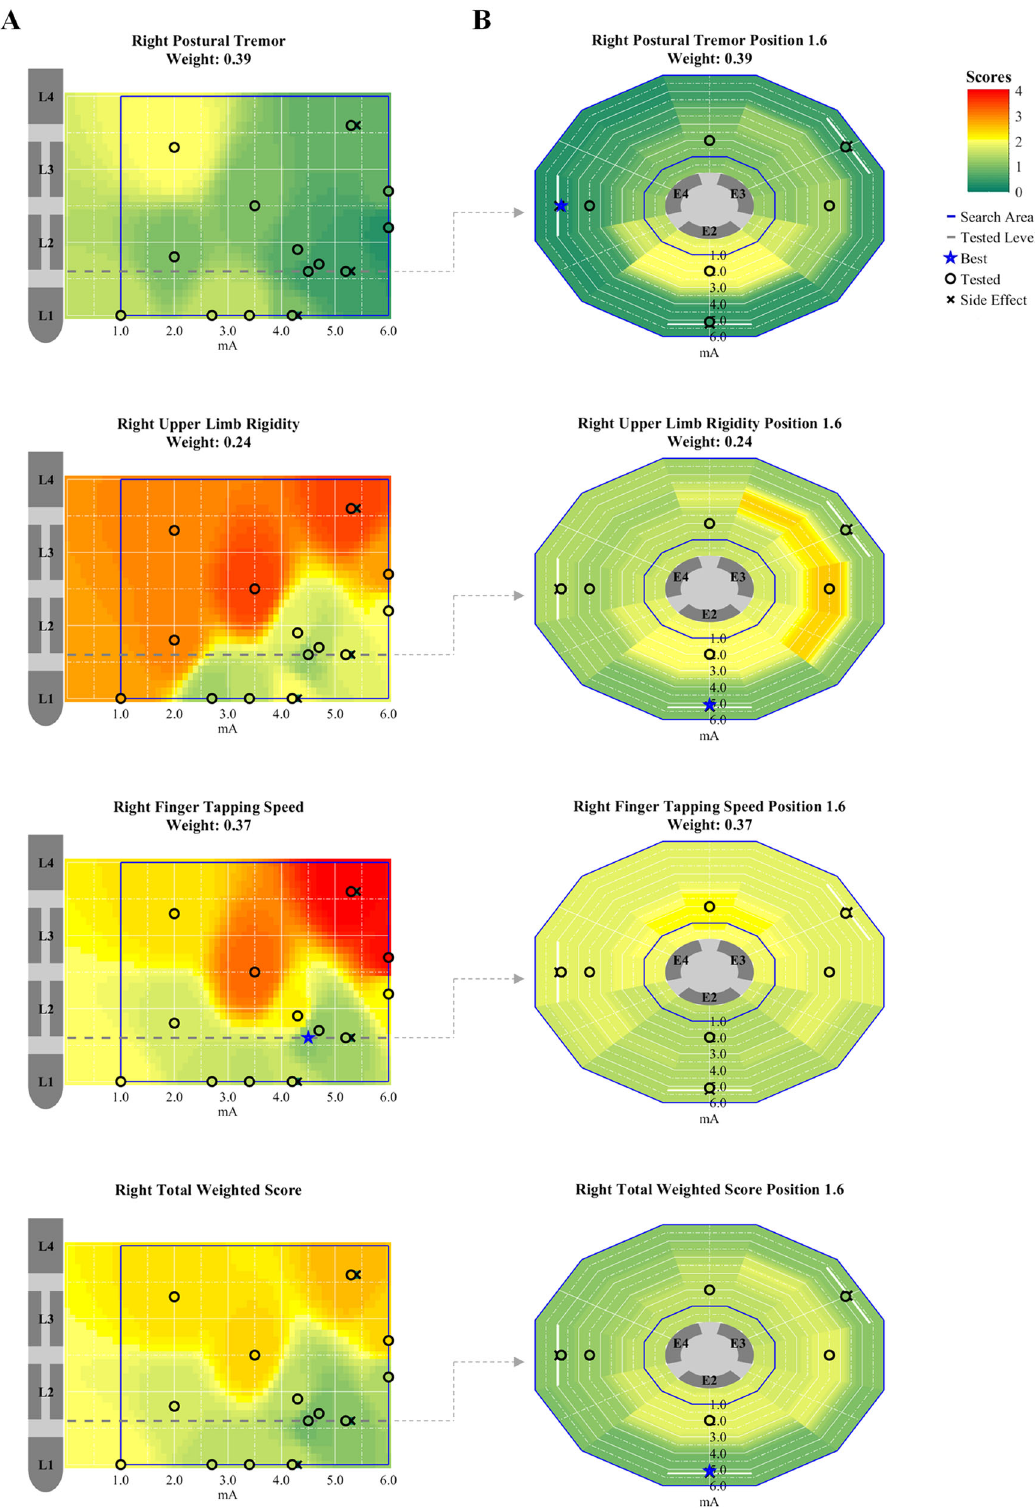
Fig. 1 Exemplary score maps showing responses to AgP DBS settings for subject ’ s 0309-010 right body side symptoms (postural tremor, upper limb rigidity, fi nger tapping speed, and total weighted score). Score maps were generated for the A ring and B directional mode stages. Dashed lines on the ring mode stage score maps indicate the level at which the directional mode stage was performed. Red colored areas represent high symptom load and less DBS ef fi cacy, whereas dark green colored areas low symptom load and high DBS ef fi cacy. Note that score maps differed slightly between individual